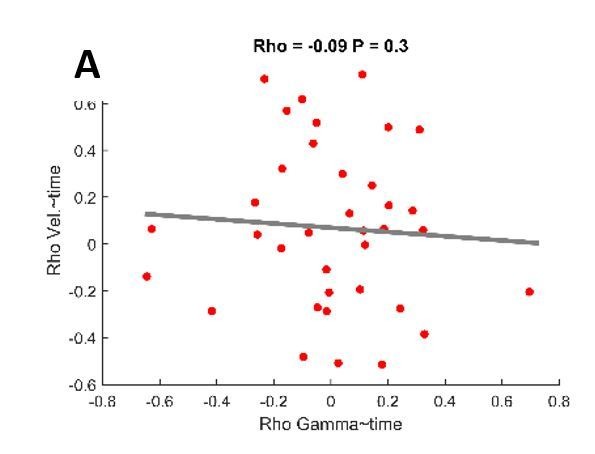
Changes in maximal velocity and gamma synchronization over trials do not correlate.Spearman’s correlation was conducted for both maximal velocity and averaged gamma power over trials. No robust correlation was seen between the correlation coefficients of both variables (Rho=-0.09, P=0.3).